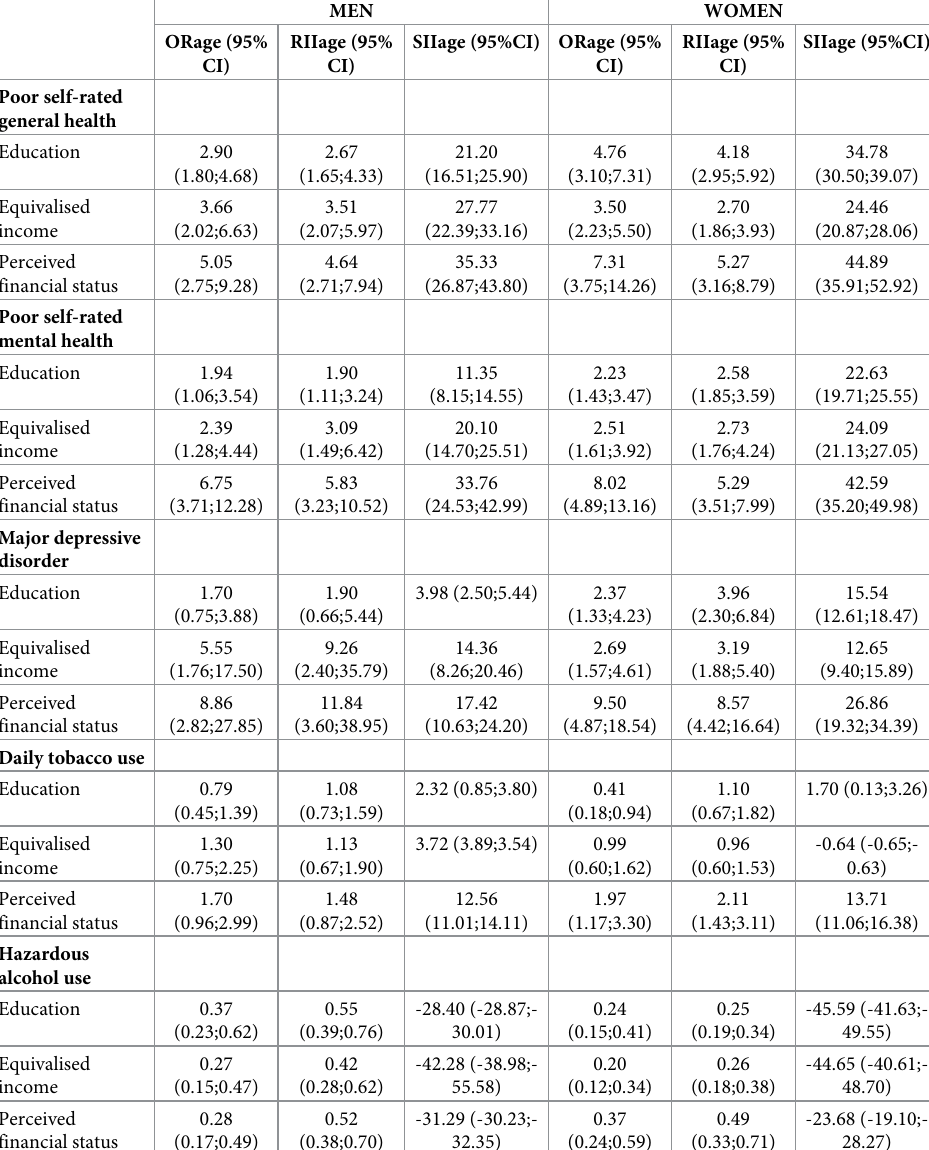
Table 2. Socioeconomic inequalities in health and substance use disorders according to socioeconomic position indicators: Odds ratio, relative index of inequality and slope index of inequality controlled for age (95% confi- dence interval).